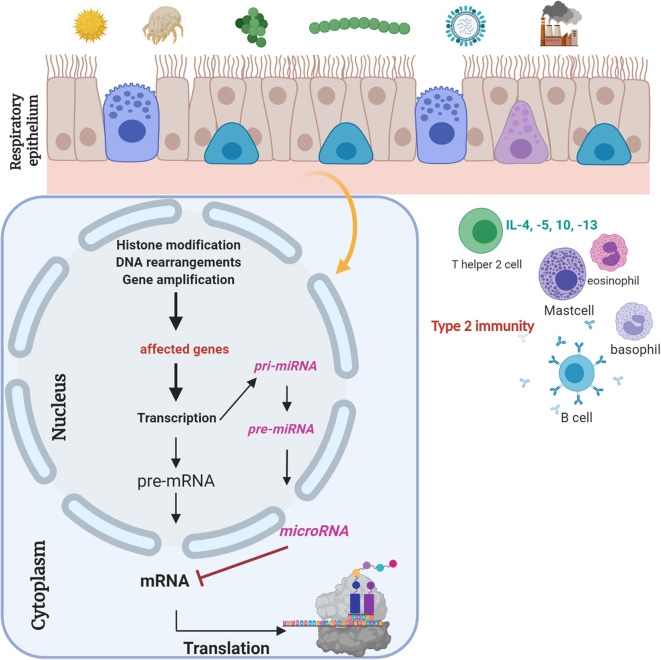
Respiratory epithelium is a gateway for “biocode” research. Respiratory epithelium is constantly connected to environmental factors. Different trigger factors can lead to epigenetic changes. Gene regulatory molecules, i.e., microRNAs, are small non-coding RNA molecules with a length of 21–23 nt, which regulate gene regulation posttranscriptionally (20). Their role and the role of siRNAs and medium and large RNA molecules as potential biomarkers will be analyzed. Experimental design of ongoing experiments to define biomarkers for clinical and therapeutic implementation. This figure was created with BioRender.com.